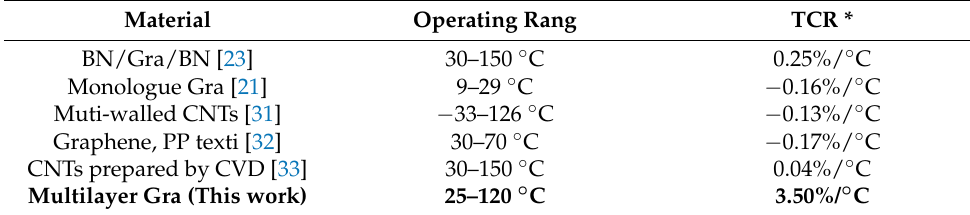
Table 1. Graphene temperature sensors in different